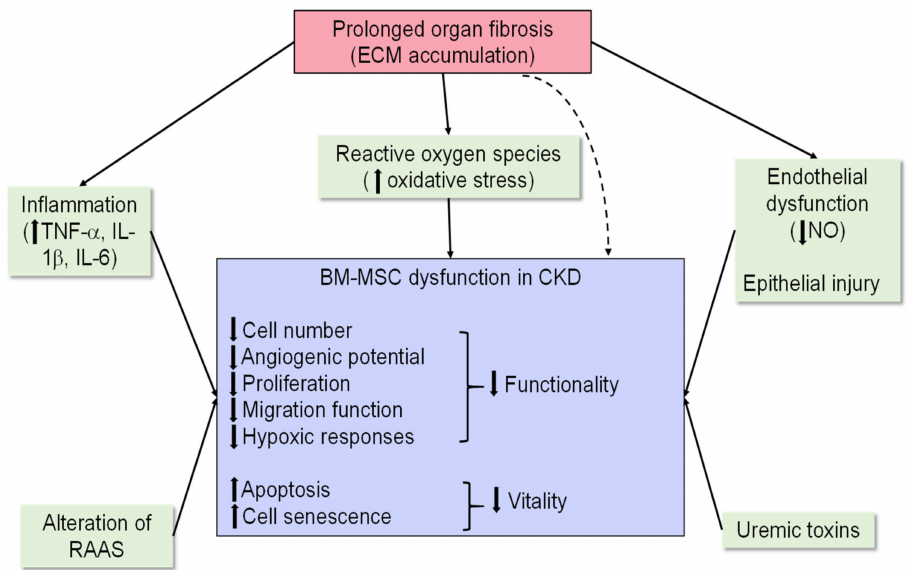
Figure 4. The functionality (indicated by the number of circulating stem cells and their tissue- reparative efficacy) and vitality (cellular survival and senescence) of transplanted BM-MSCs can both be impaired due to a deleterious organ environment created by prolonged organ fibrosis and other factors depicted above, which override the tissue-reparative benefits of BM-MSCs in